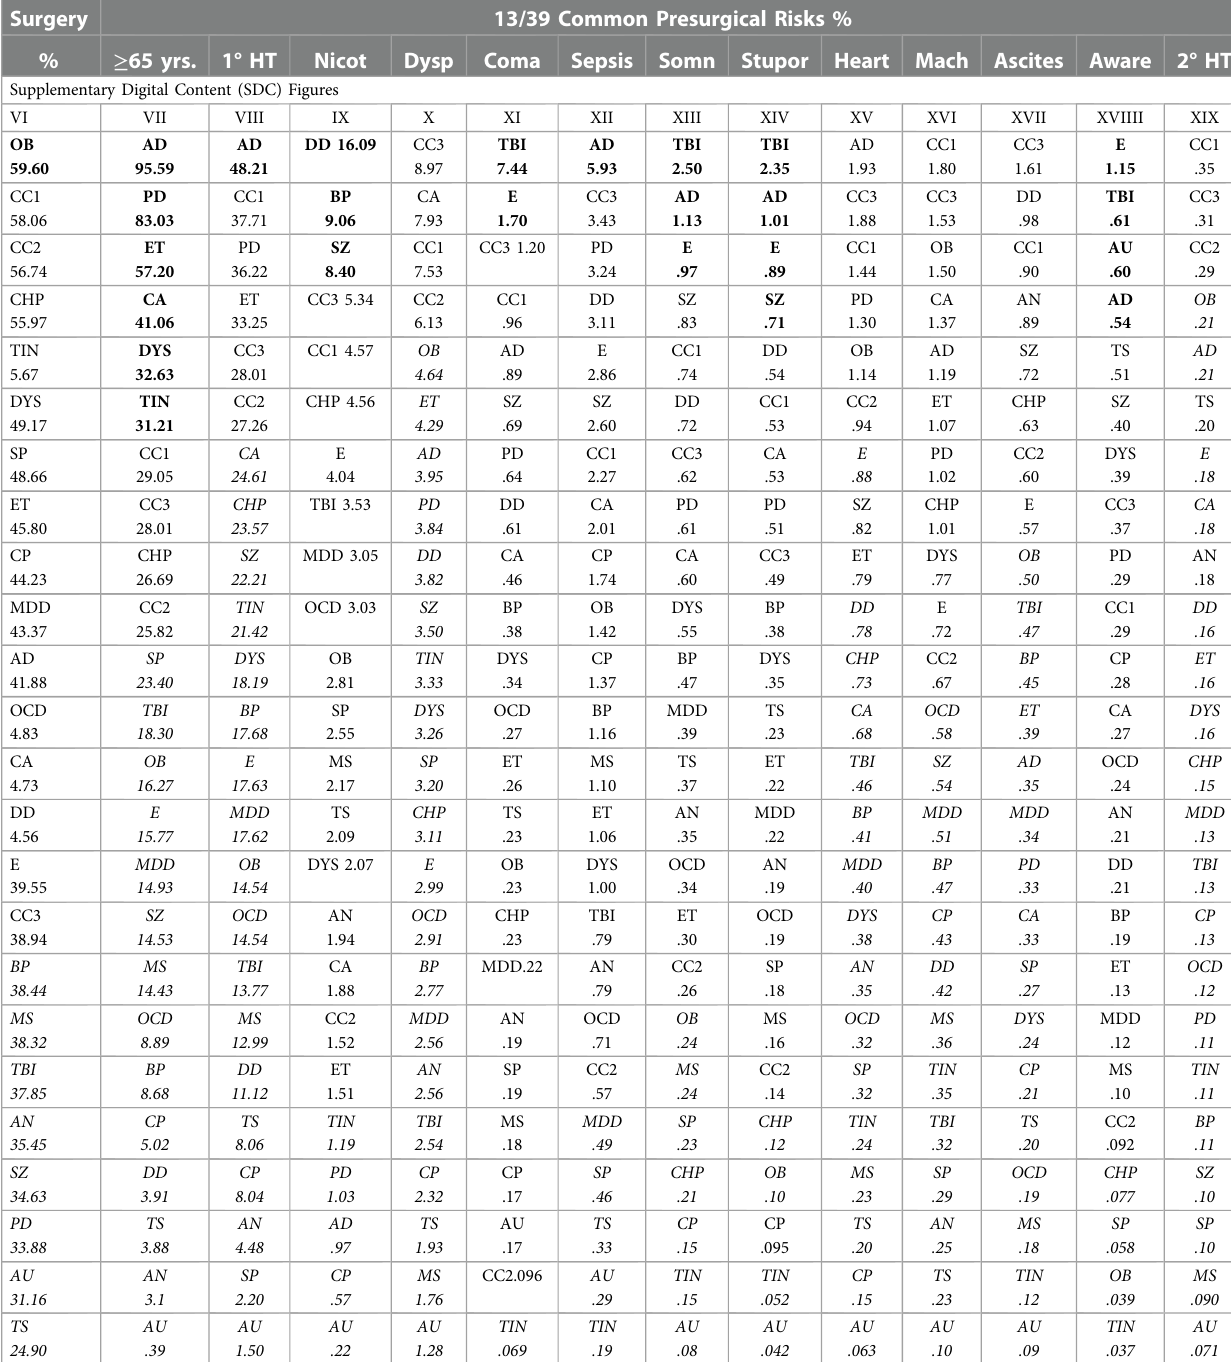
TABLE 5 Logistic regression analysis of all surgical frequencies and presurgical risks. Surgery 13/39 Common Presurgical Risks % % ≥ 65 yrs. Dysp Coma Sepsis Somn Stupor Heart Mach Ascites Aware 2°